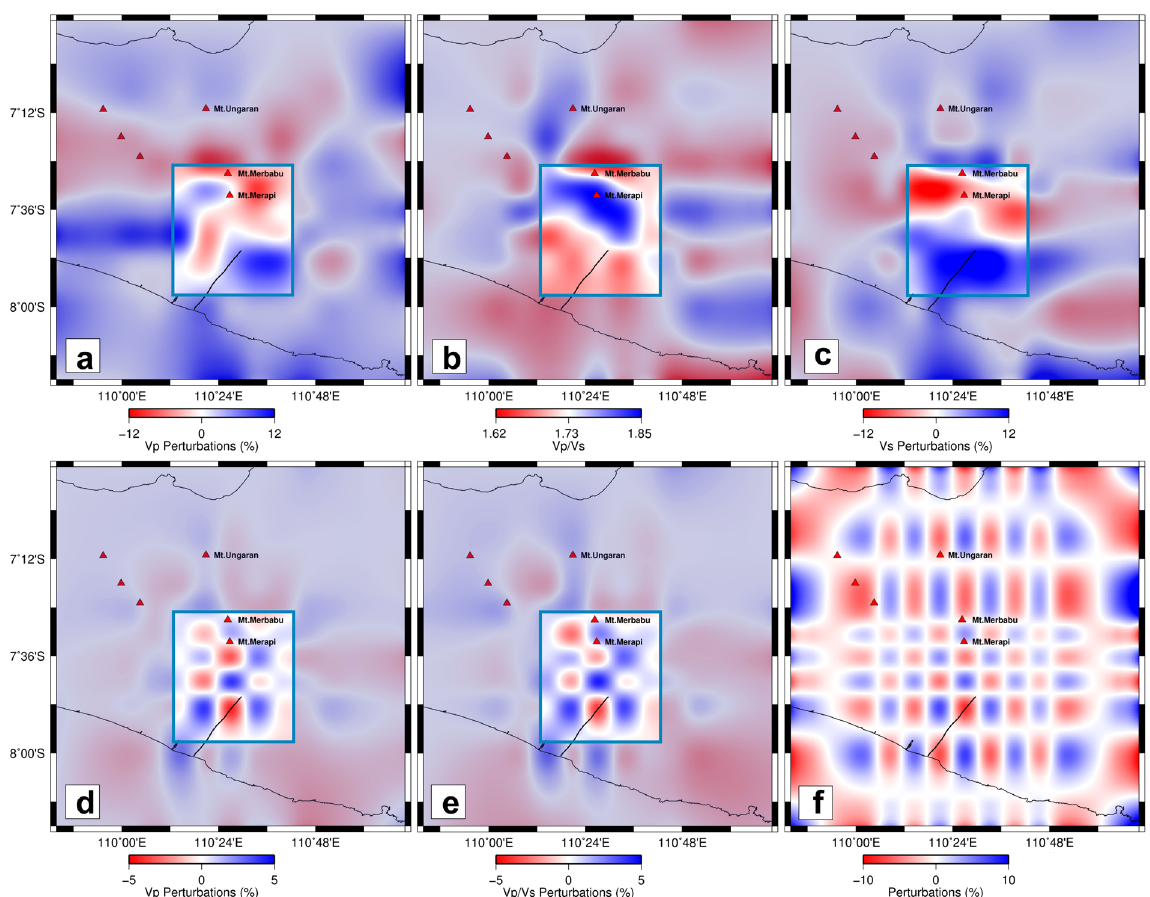
Figure 2. Map views of seismic velocity structure at 15 km depth below MSL. ( a ) Vp, ( b ) Vp/Vs, ( c ) Vs, ( d ) checkerboard recovery for Vp, ( e ) same as ( d ) but for Vp/Vs, and ( f ) checkerboard input model for Vp and Vp/ Vs with input perturbations = + 10% for both Vp and Vp/Vs. Notice that the recovery around Merapi (inside the blue box) is good owing to the DOMERAPI data; the area with poor resolution is dimmed. Here, Vp and Vs are plotted as perturbations relative to the 1D velocity model based on Koulakov et al . 18 and Vp/Vs is plotted as absolute values. The high Vp/Vs is interpreted as an intermediate magma reservoir under Merapi as further illustrated in Figs 3 and